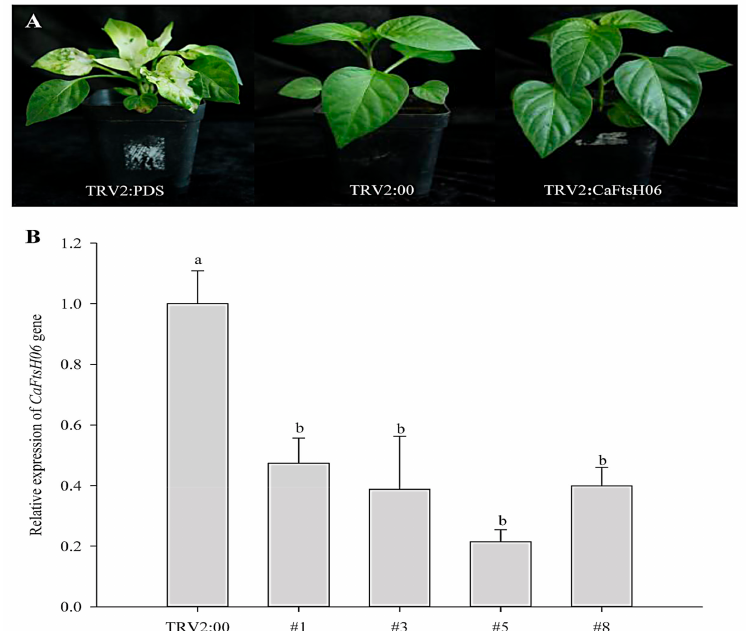
Figure 5. The phenotypes and silencing efficiency of CaFtsH06 in pepper leaves. ( A ) The phenotypes of TRV2: CaPDS positive control plants, TRV2:00 negative control plants, and pTRV2: CaFtsH06 - silenced plants are shown, respectively. ( B ) Silencing efficiency of CaFtsH06 in pepper. Different letters denote statistical significance ( p < 0.05).